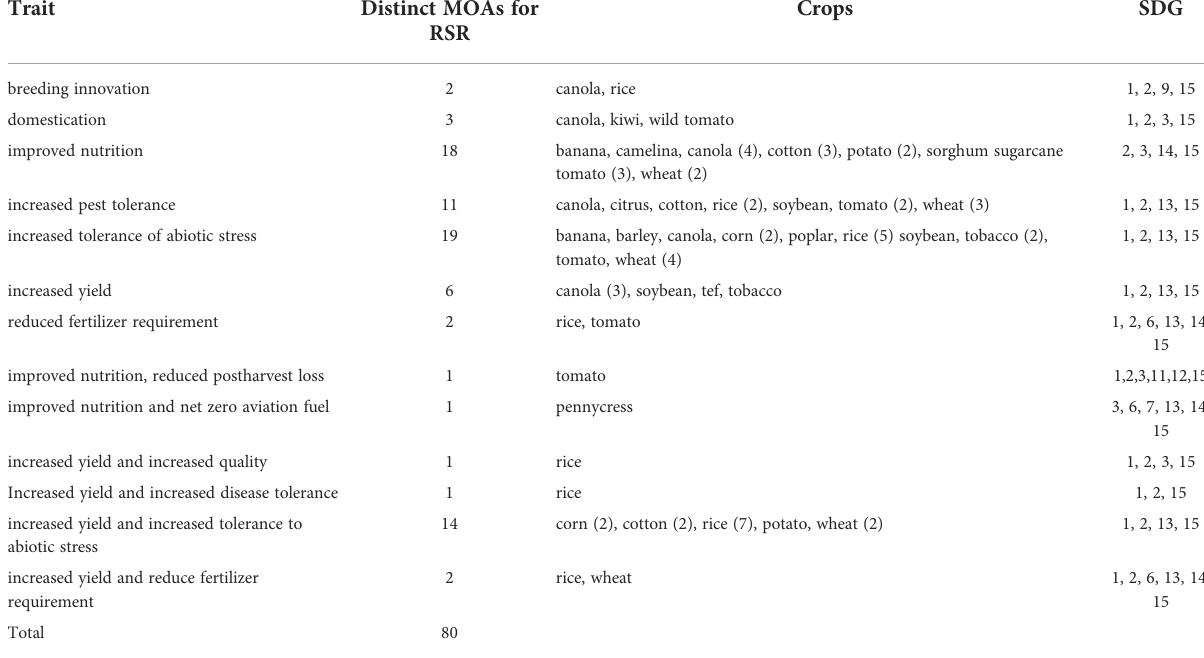
TABLE 2 Crops that could contribute to sustainable agriculture that would undergo regulatory status review.